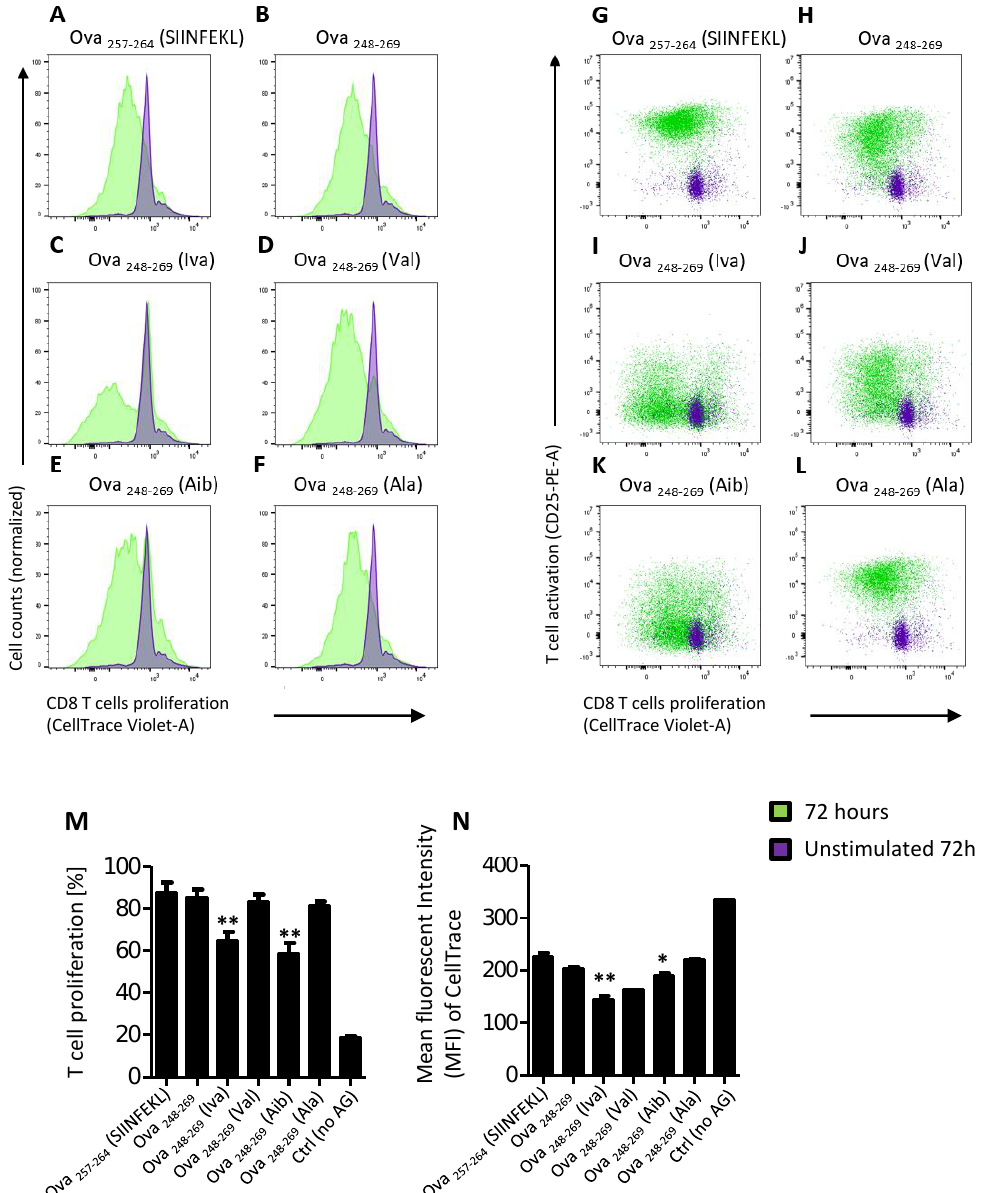
Figure 3. Iva- or Aib promote proliferation of OT-I cells. Cell proliferation was assessed by measuring dilution of CellTrace Violet dye over 72 h following stimulation with the test peptides. ( A – L ) Representative images show a histogram shift ( A – F ) of unstimulated control cells (purple histogram) against cells stimulated with peptides (green). ( G – L ): Representative images show dot plots of activated (CD25 expressing) cells proliferating (decrease in CellTrace) cells when unstimulated (purple) or stimulated with peptides (green). The native ova-control peptides ( A , G ): short Ova 257-264 (SIINFEKL) or ( B , H ): longer Ova 248-269 ). Ova peptides substituted with exo-amino acids ( C , I ): Ova 248-269 (Iva) and ( E , K ): Ova 248-269 (Aib) or peptides substituted natural amino acids ( D , J ): Ova 248-269 (Val) and ( F , L ): Ova 248-269 (Ala). ( M ): Geometric Mean (CellTrace) of proliferating CD8 T cells. Proliferation with peptide Ova 248-269 (Iva) or Ova 248-269 (Aib) are statistical significant ( p -value < 0.01) compared to the control peptides Ova 248-269 ( p -value 0.0032 and p -value 0.0015) and control Ova 248-269 (Val) and Ova 248-269 (Ala), p -value 0.004 and p -value 0.0021, respectively. ( N ): Mean fluorescent Intensity (MFI) of proliferating CD8 T cells expressing CD25. Peptide Ova 248-269 (Iva) or Ova 248-269 (Aib) are statistical significant compared to the control peptides Ova 248-269 (**: p -value < 0.01; *: p -value < 0.1). Three technical replicas were performed for each of the three biological